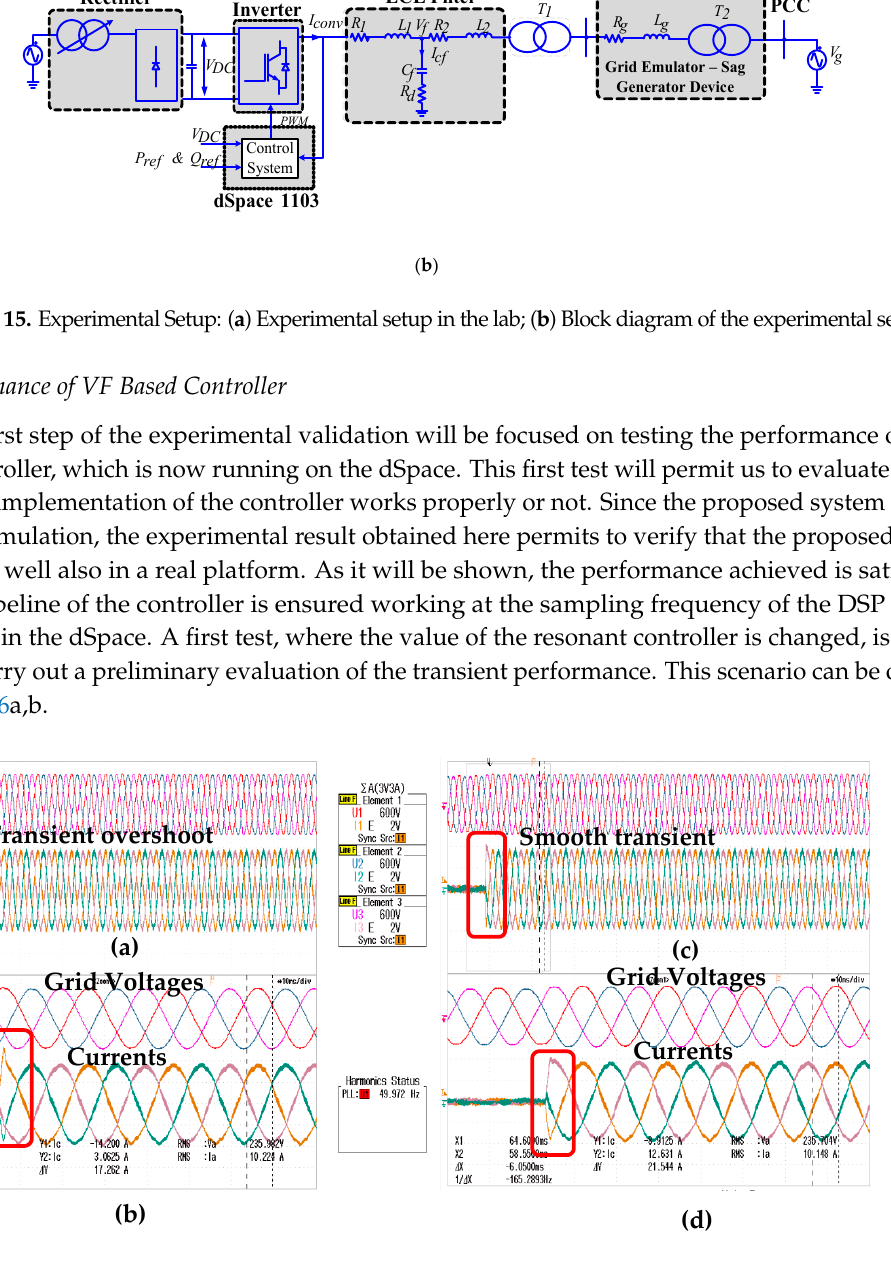
Figure 16. Experimental results captured from the oscilloscope: ( a ) Experimental results of grid voltages and current when K p = 7 and K r = 70; ( b ) Zoom in version of the grid voltages and currents shown in ( a ); ( c ) Experimental results of grid voltages and current when K p =7 and K r = 19; ( d ) Zoom in version of the grid voltages and currents shown in ( c ).